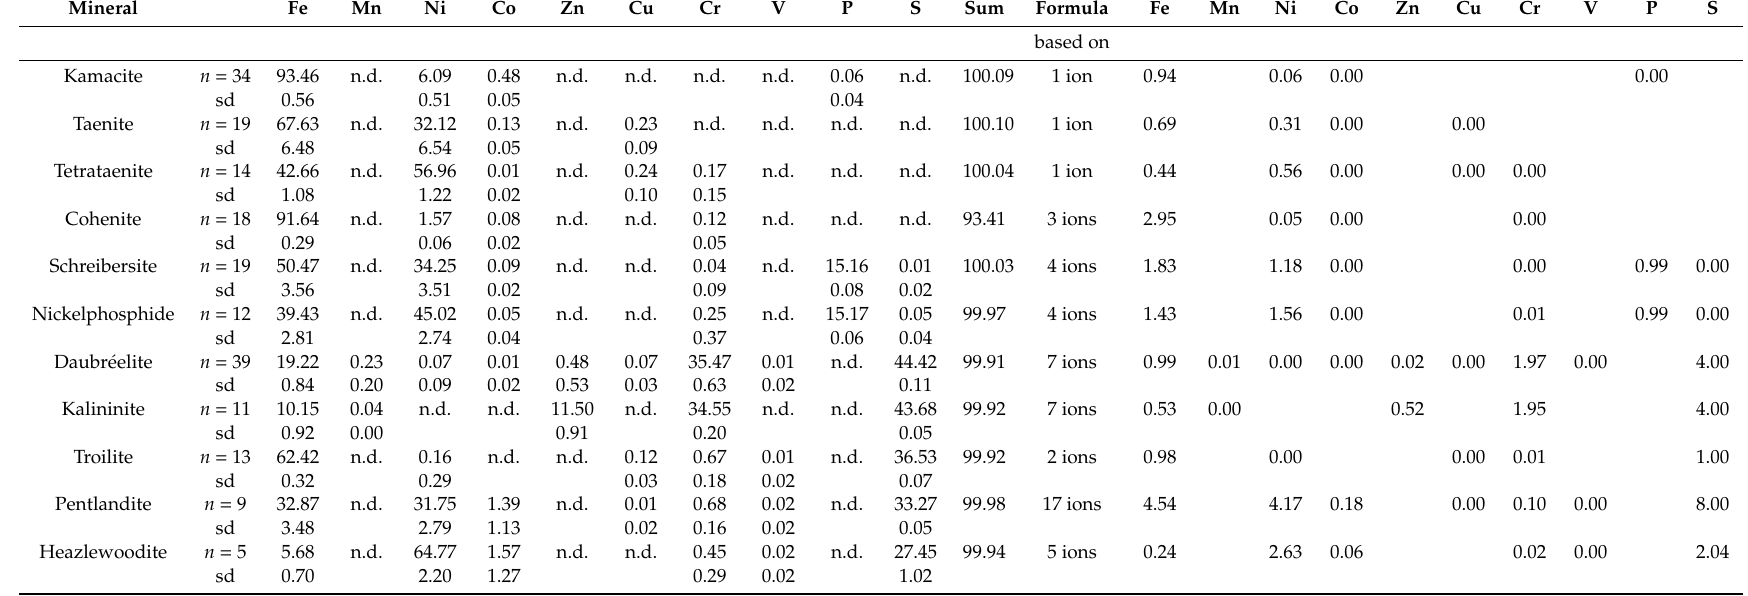
Table 1. Chemical composition (WDS, wt. %) of the essential minerals in the Uakit iron